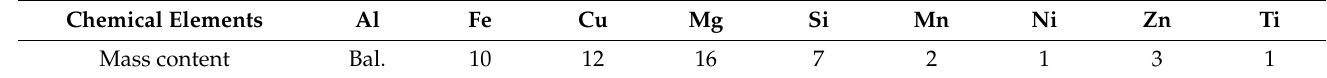
Table 1. Chemical composition of initial aluminum plates (mass content in ppm). Chemical